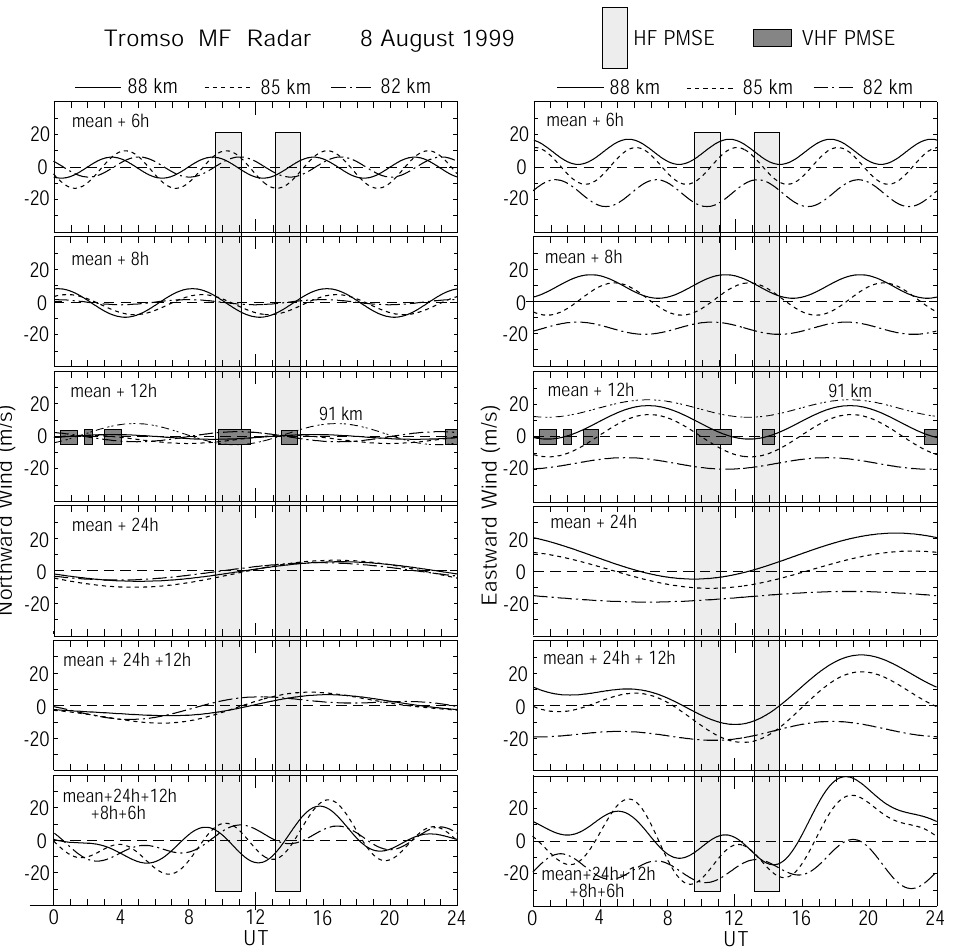
Fig. 6. Time variations of (left) northward and (right) eastward tidal components at three altitudes reconstructed from mean wind and 24-h, 12-h, 8-h and 6-h amplitudes and phases. The mean +12-h components at 91km altitude are also shown. PMSE occurrences detected with the Hankasalmi HF and Esrange VHF radars are